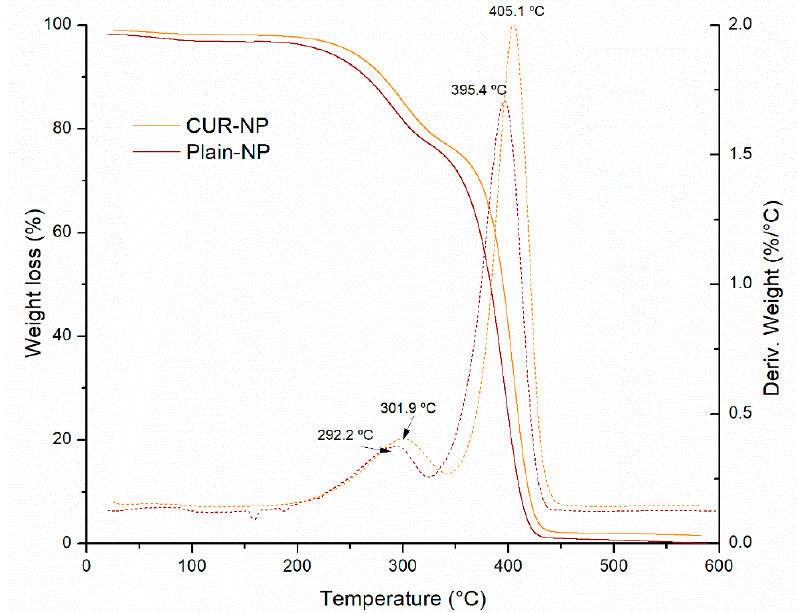
Figure 4. TGA curves of Plain-NP and CUR-NP. Dashed and dotted lines represent the derivative of % weight loss as a function of temperature.